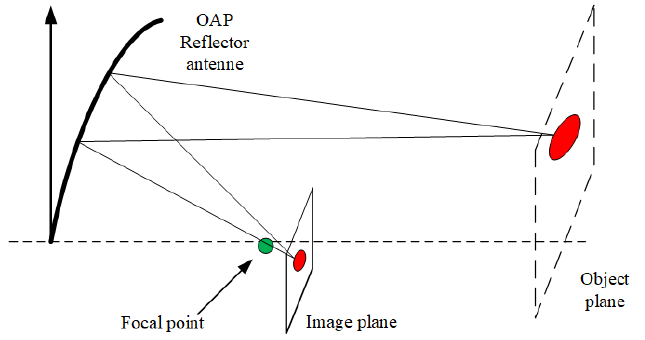
Figure 1. Schematic diagram of an off-axis parabolic (OAP) imaging